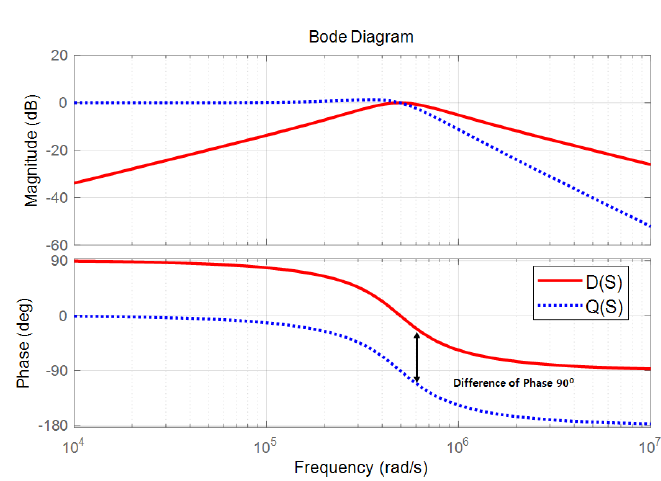
Figure 9. Bode plot of second-order generalized integrator-quadrature signal generator (SOGI-QSG).